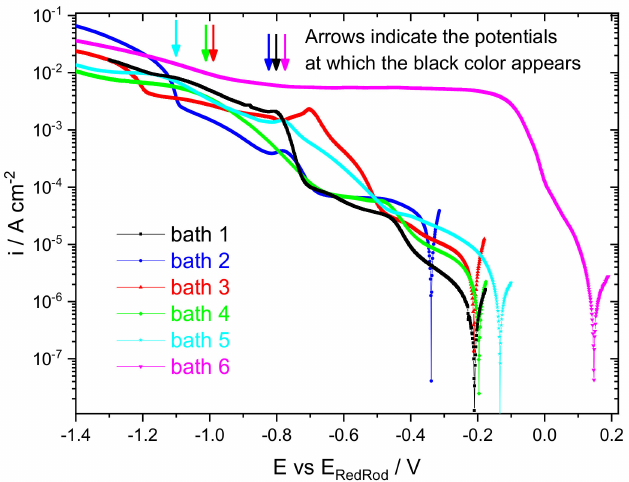
Figure 4. Polarization curves of Ni in the bath solutions presented in Table 1.